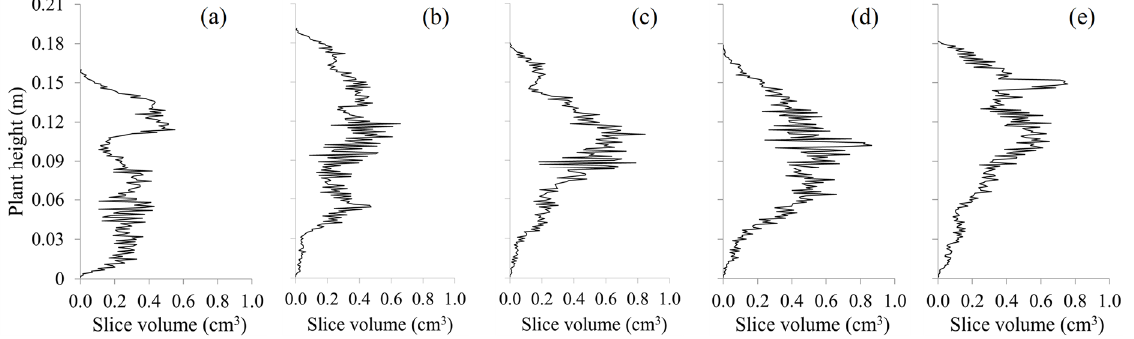
Figure 7. Vertical canopy volume profiles obtained using D max = 0.15 cm and slight height S = 0.1 cm considering a typical strawberry plant from time series LiDAR data acquired on 14, 28, 50, 63 and 77 days after planting (DAP) shown in ( a – e ), respectively.